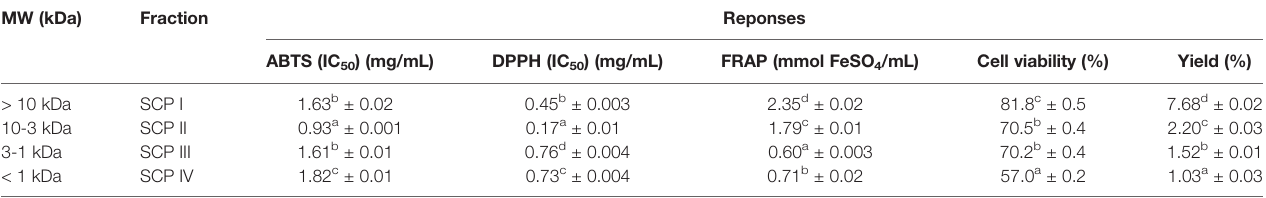
TABLE 7 | Antioxidant and UV-B protective activities, and fraction yield from the fractionation of sea cucumber hydrolysates prepared with papain. MW